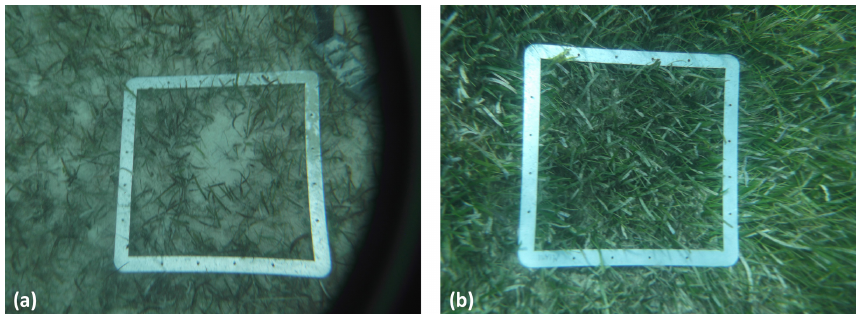
Figure 3. Examples of sea-floor vegetation also showing the metal frame used during sampling. (a) Sparsely to moderately vegetated area typical for an M2 vegetation habitat, with a mix of calcareous algae and some seagrass ( Thalassia ). (b) Densely vegetated sea floor covered by seagrass typical for an M3 habitat. Photo: Sonja Reich, 2012.